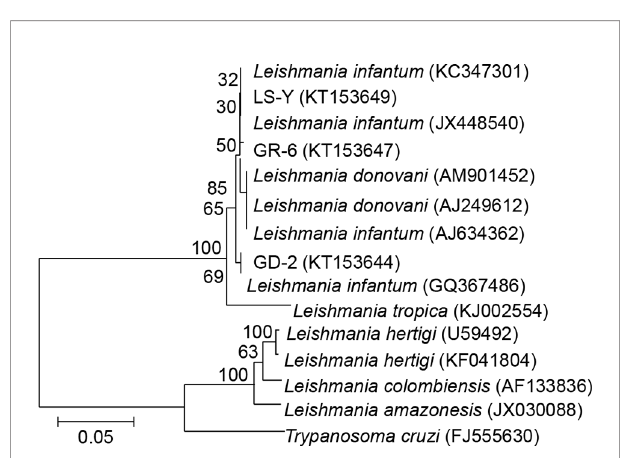
FIGURE 4 | Phylogenetic analysis of ITS genes in Leishmania . LS-Y (MHOM/ CN/08/JS-1), positive control; GR-6, blood from kala-azar patient; GD-2, animal tissue from